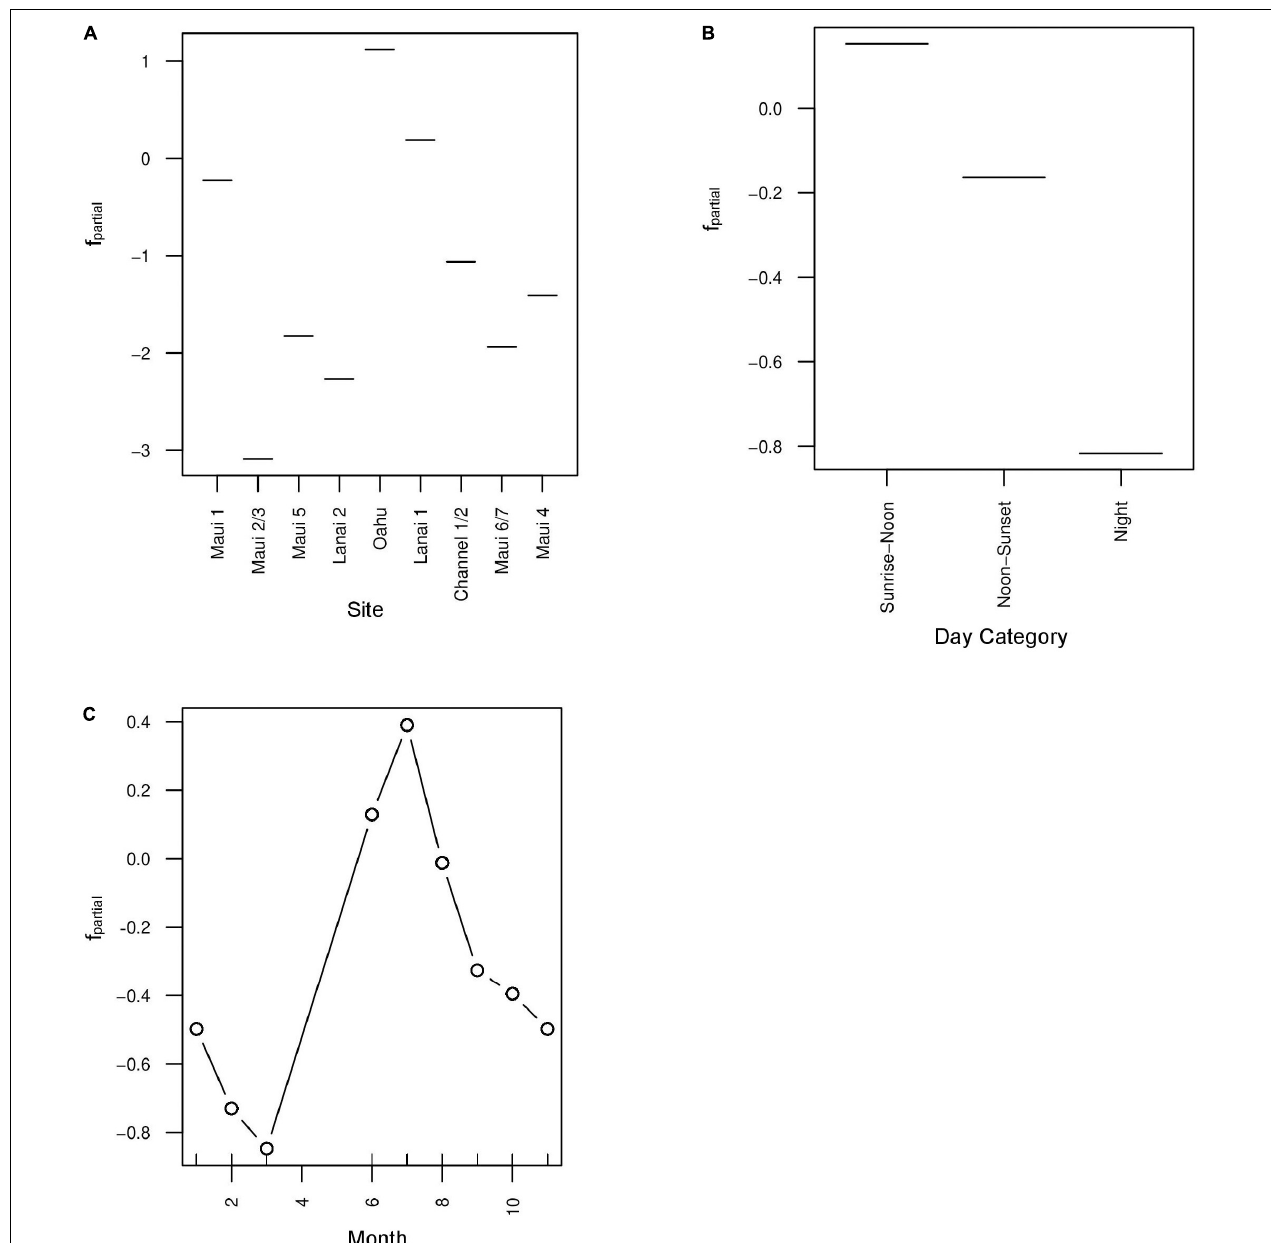
FIGURE 5 | Partial effects plots of the mu parameter in the boosted GAM for three selected base learners: site (A) , day category (B) , and month (C) . To apply a beta regression to the model, Acoustic Activity Index (AAI) was divided by 3.5 in order to bound its values between 0 and 1. Month was included as a cyclic smoother to account for variation in acoustic activity within the